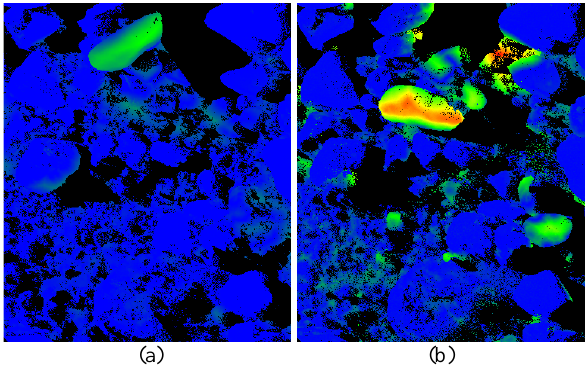
Figure 2. Example of distances between clouds t1 and t2 (description in the text); blue colour indicates zero distance